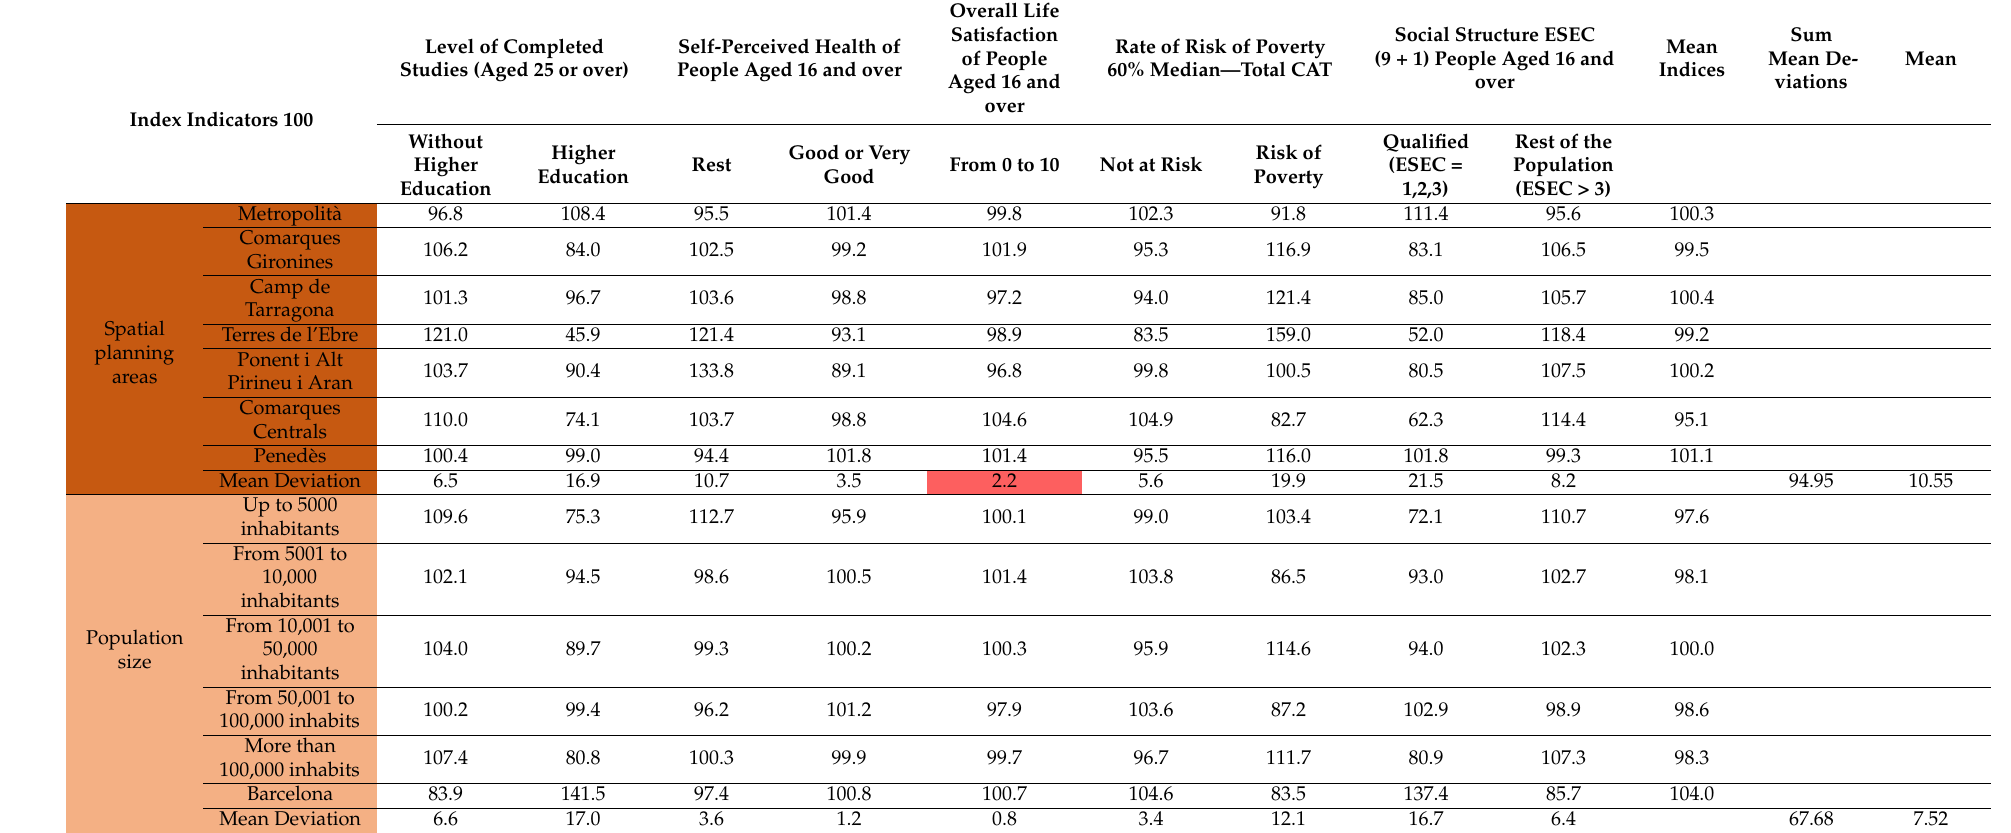
Table 2. Summary of the indicators analysed and their deviations. Catalonia; base: